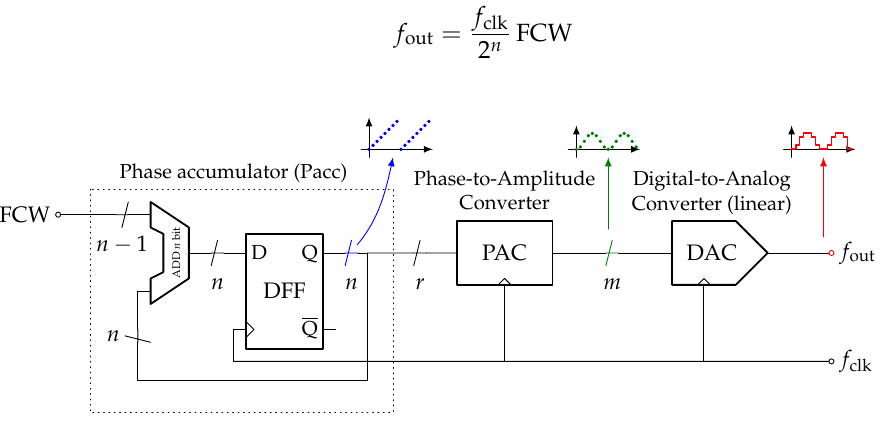
Figure 12. DDFS basic structure (DFF: